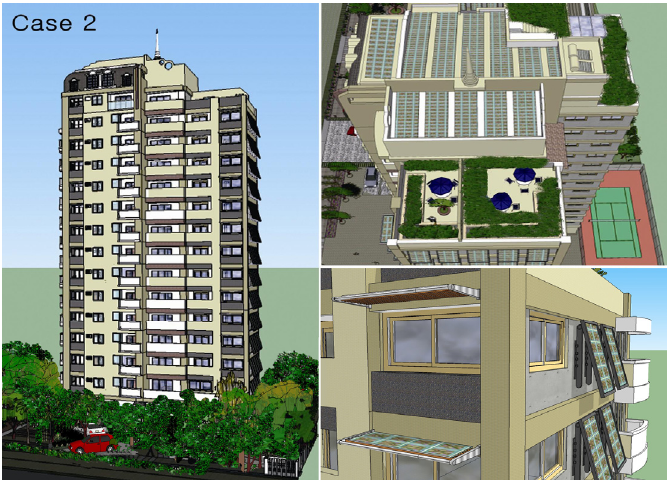
Figure 6. Design concepts for Case